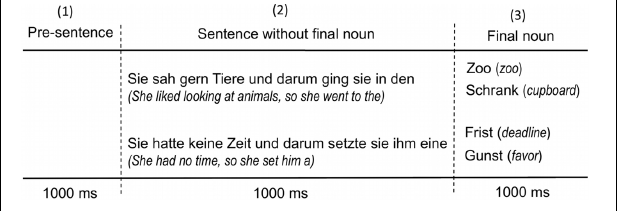
FIGURE 2 | The three sentence intervals (1, 2, 3) relevant for statistical analysis of the EEG